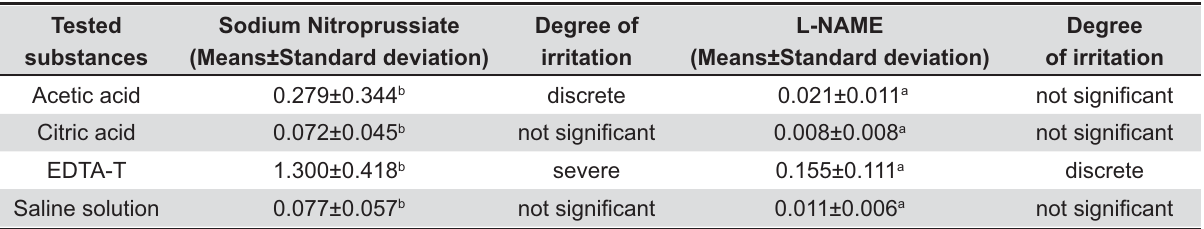
Statistical differences are indicated by different lletters in rows (Kruskal Wallis test, P<0.05).